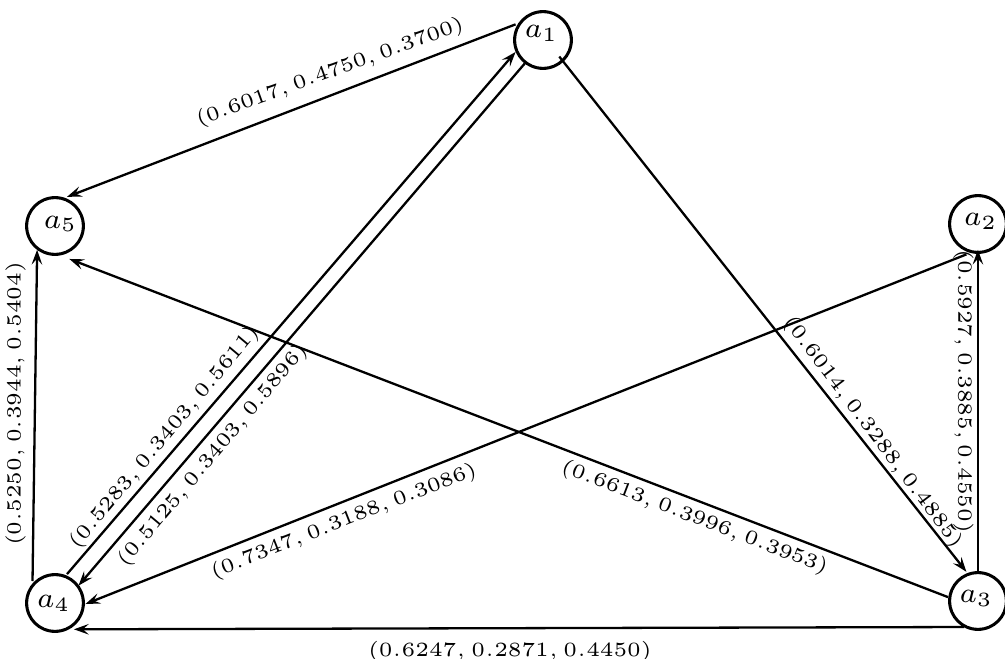
Figure 22. Partial directed model of the combined Figure 22: Partial directed model of the combined SFPR